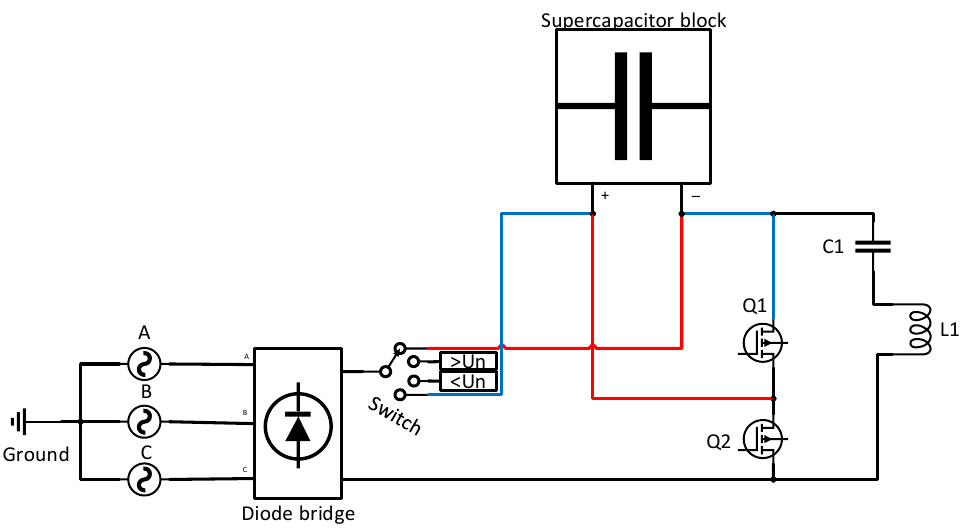
Figure 6. Supercapacitor connection.